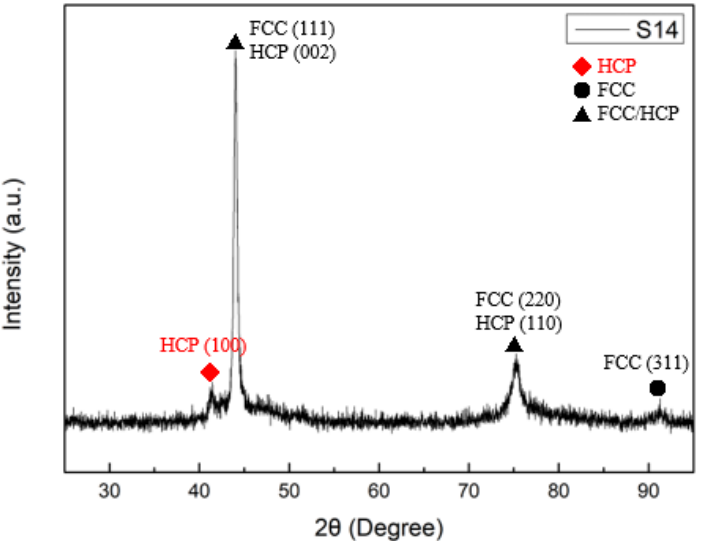
Figure 5. GIXRD diffraction pattern of S14.